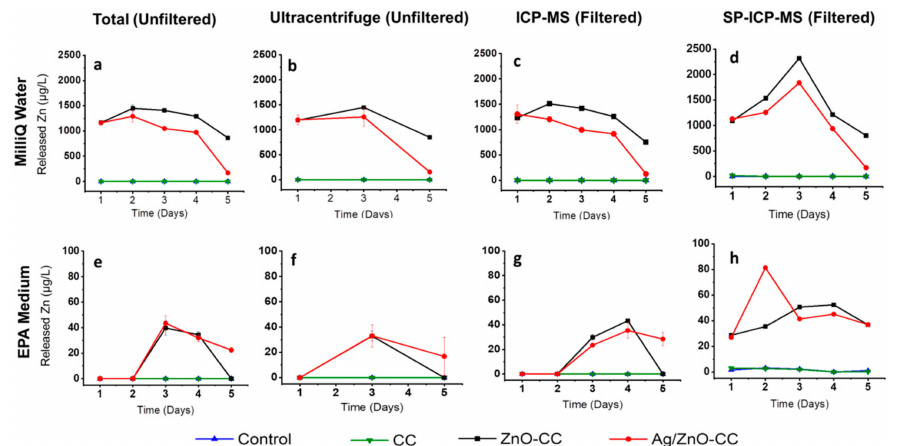
Figure 5. ZnO-NW / dissolved Zn released from the carbon cloth in MilliQ or EPA media. ( a , e ) Total release of ZnO-NW / dissolved Zn. ( b , f ) Dissolved Zn release measured by ultracentrifugation. ( c , g ) Released ZnO-NW / dissolved Zn in the filtered solutions using ICP-MS. ( d , h ) Dissolved Zn in the filtered solution measured by SP-ICPMS. (Note: the blue line of the control and green line of the CC are the